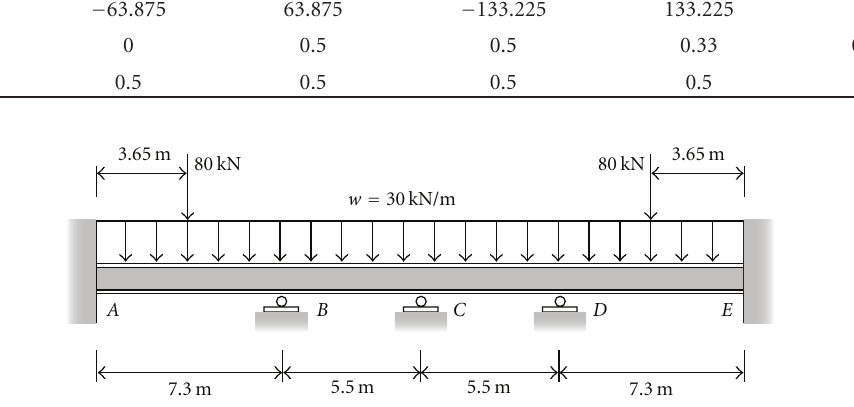
Figure 8: Continuous beam for the third example.